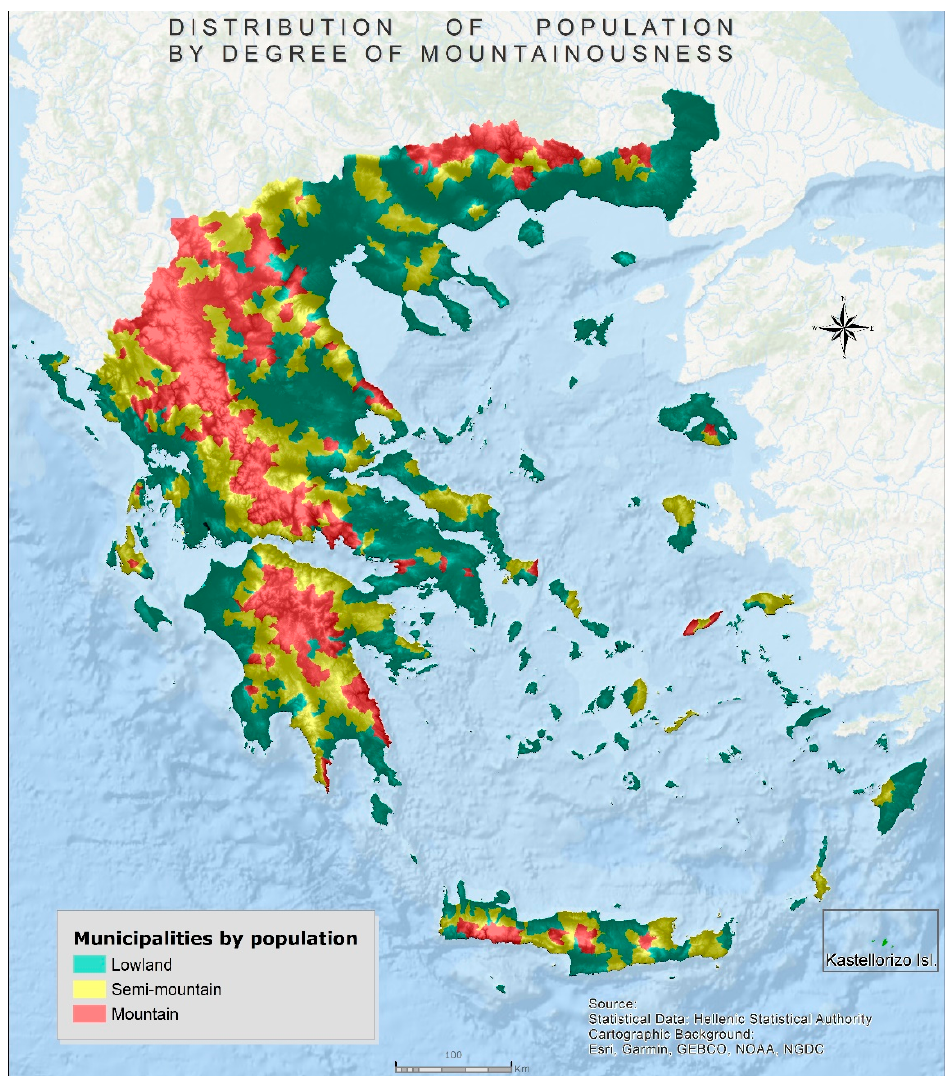
Scheme 2. Distribution of population by degree of mountainousness.